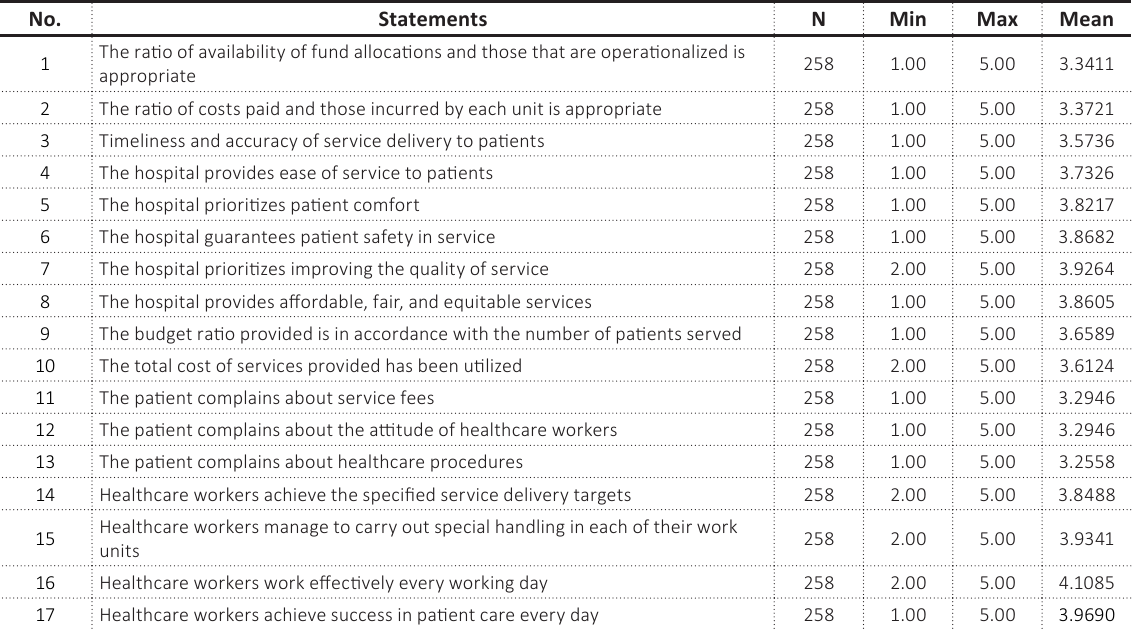
Source: Authors’ elaboration.